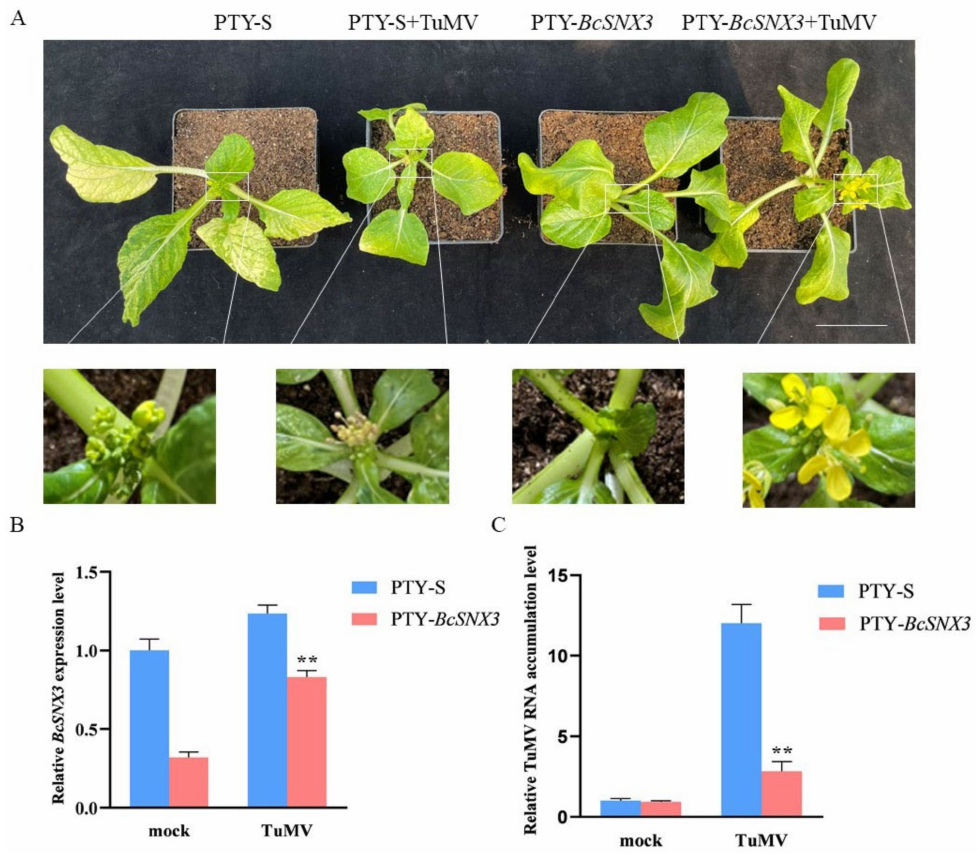
Figure 7. The silencing of BcSNX3 suppressed TuMV infection in 49CX, a variety of pak-choi. ( A ) Viral symptoms in plants pre-inoculated with PTY-S (control), PTY- BcSNX3 (silencing the BcSNX3 ), for 10 days and then infected by TuMV-GFP. Plants were photographed at 20 dpi. Scale bar = 5 cm. ( B ) The expression level of BcSNX3 in the above plants. RNA was extracted from systemically infected leaves at 20 dpi. The values are presented as means of fold change ± SD relative to the control plants (pretreated with PTY-S). Error bars represent the SD of three times experiments. ( C ) Quantification of TuMV genomic RNA in the above plants. Significant differences were calculated using Student’s t -test, ** p <